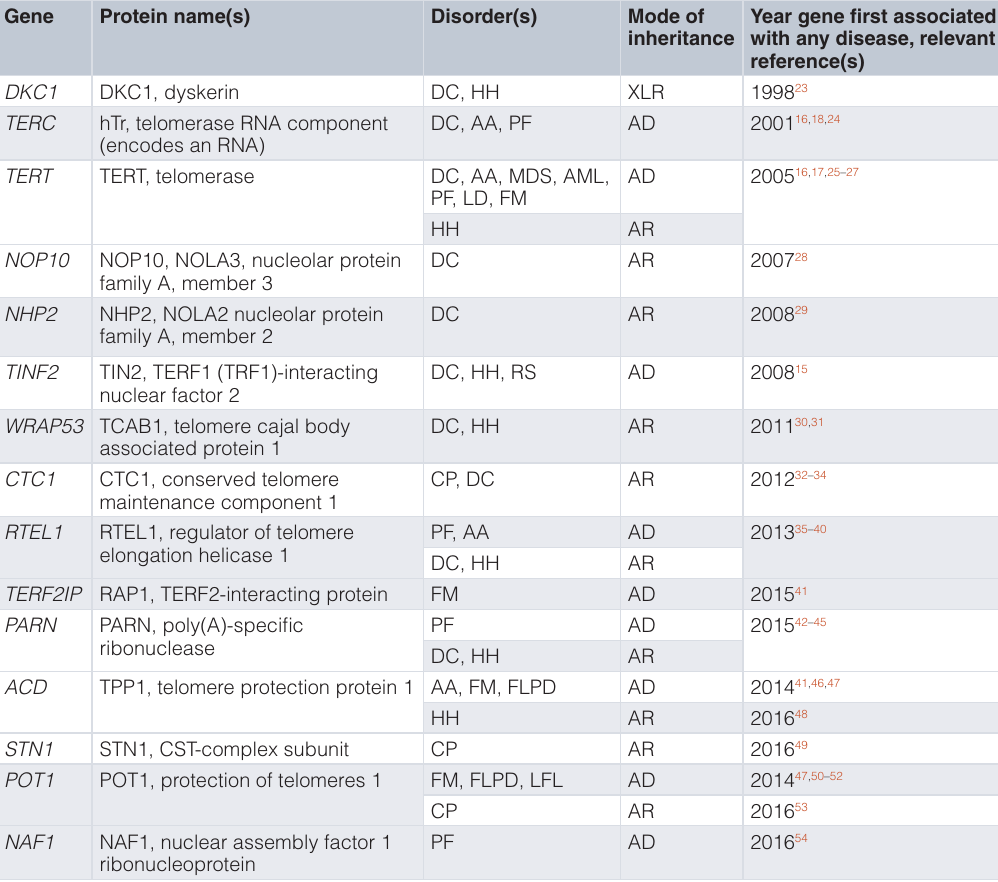
Table 2. Germline genetics of telomere biology disorders.